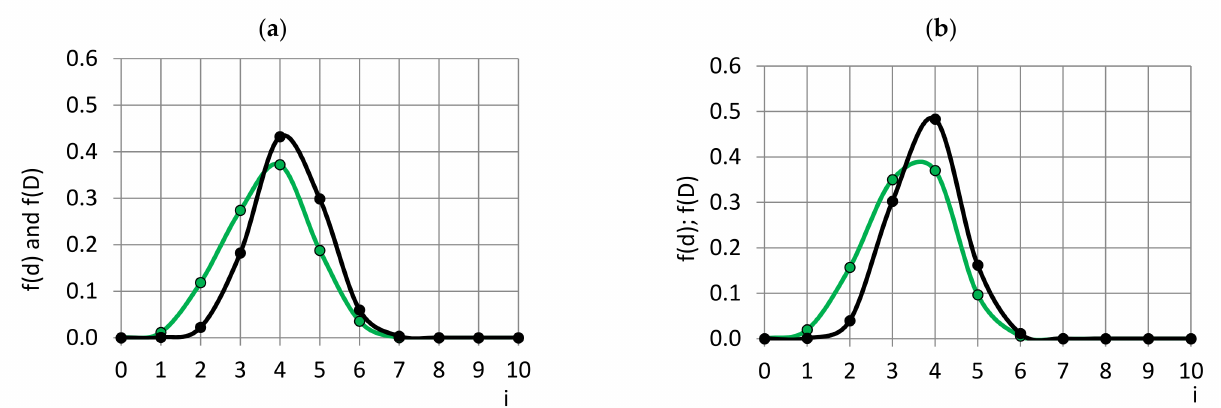
Figure 12. PDFs of circles’ diameters, d, (green) and bubbles’ diameters, D, (black) of PU foams; concentration of filler ( a ) η = 0.0% and ( b ) η = 5.0%.